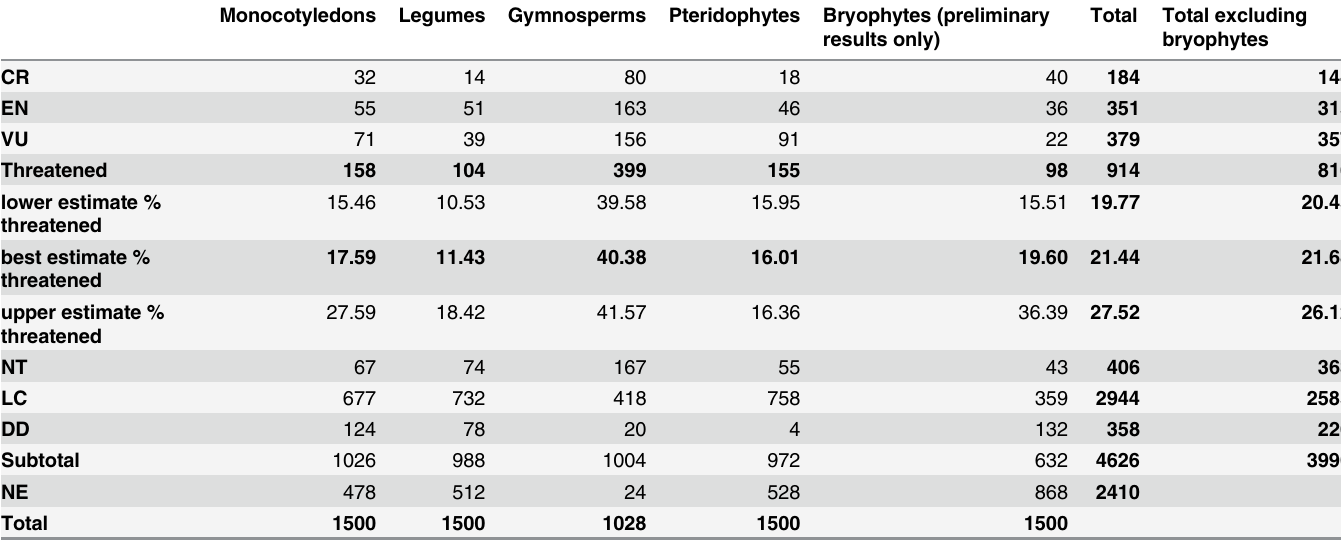
Table 1. Numbers of species from the combined SRLI for Plants sample of gymnosperms, monocots, legumes and pteridophytes by IUCN Red List Category for each group of plants. Monocotyledons Legumes Gymnosperms Pteridophytes Bryophytes (preliminary